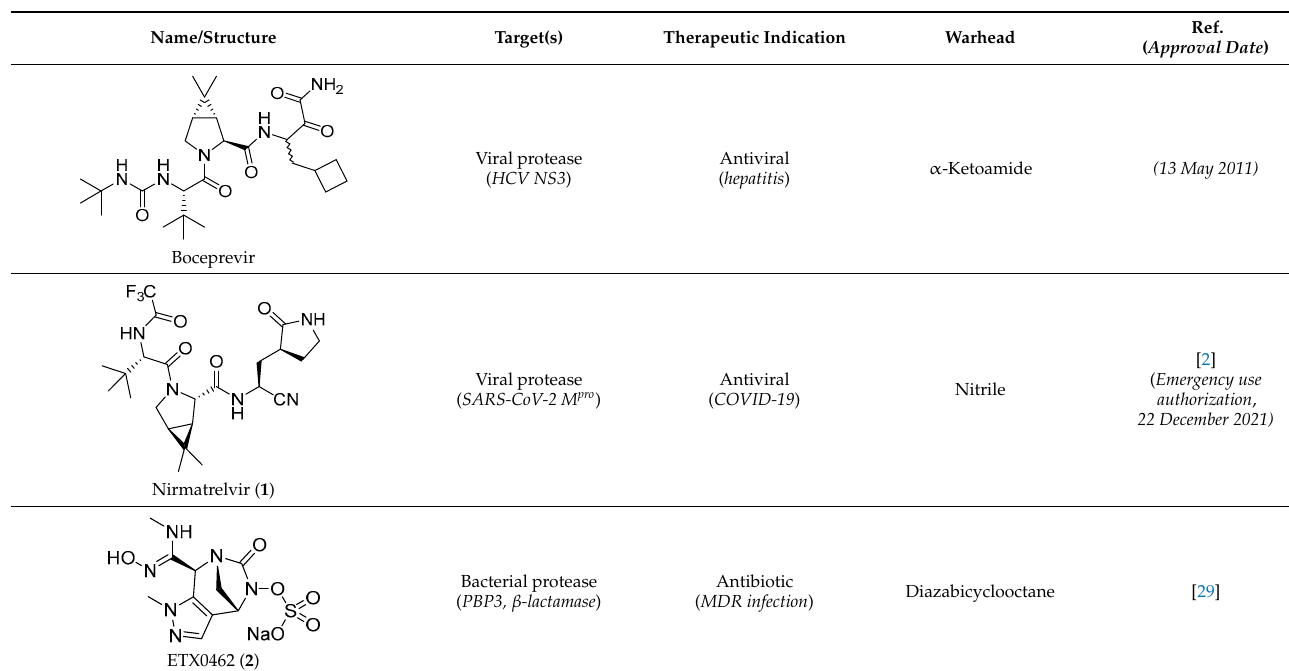
Table 1. Representative examples of conventional covalent inhibitors.